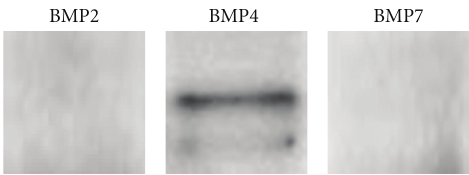
Figure 5: Western blot analysis for BMP. The tumor tissue expres- sed BMP-4 but not BMP-2 and